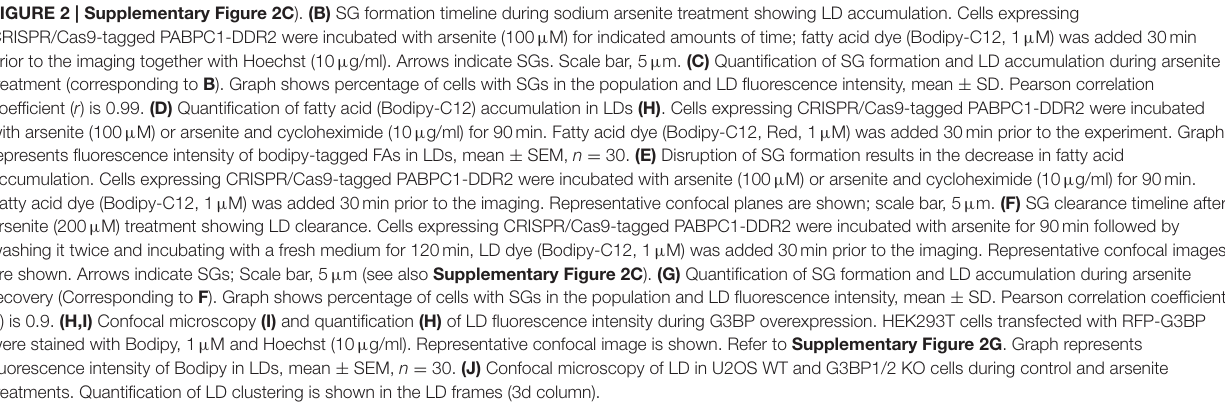
FIGURE 2 | Supplementary Figure 2C ). (B) SG formation timeline during sodium arsenite treatment showing LD accumulation. Cells expressing CRISPR/Cas9-tagged PABPC1-DDR2 were incubated with arsenite (100 µ M) for indicated amounts of time; fatty acid dye (Bodipy-C12, 1 µ M) was added 30min prior to the imaging together with Hoechst (10 µ g/ml). Arrows indicate SGs. Scale bar, 5 µ m. (C) Quantification of SG formation and LD accumulation during arsenite treatment (corresponding to B ). Graph shows percentage of cells with SGs in the population and LD fluorescence intensity, mean ± SD. Pearson correlation coefficient ( r ) is 0.99. (D) Quantification of fatty acid (Bodipy-C12) accumulation in LDs (H) . Cells expressing CRISPR/Cas9-tagged PABPC1-DDR2 were incubated with arsenite (100 µ M) or arsenite and cycloheximide (10 µ g/ml) for 90min. Fatty acid dye (Bodipy-C12, Red, 1 µ M) was added 30min prior to the experiment. Graph represents fluorescence intensity of bodipy-tagged FAs in LDs, mean ± SEM, n = 30. (E) Disruption of SG formation results in the decrease in fatty acid accumulation. Cells expressing CRISPR/Cas9-tagged PABPC1-DDR2 were incubated with arsenite (100 µ M) or arsenite and cycloheximide (10 µ g/ml) for 90min. Fatty acid dye (Bodipy-C12, 1 µ M) was added 30min prior to the imaging. Representative confocal planes are shown; scale bar, 5 µ m. (F) SG clearance timeline after arsenite (200 µ M) treatment showing LD clearance. Cells expressing CRISPR/Cas9-tagged PABPC1-DDR2 were incubated with arsenite for 90min followed by washing it twice and incubating with a fresh medium for 120min, LD dye (Bodipy-C12, 1 µ M) was added 30min prior to the imaging. Representative confocal images are shown. Arrows indicate SGs; Scale bar, 5 µ m (see also Supplementary Figure 2C ). (G) Quantification of SG formation and LD accumulation during arsenite recovery (Corresponding to F ). Graph shows percentage of cells with SGs in the population and LD fluorescence intensity, mean ± SD. Pearson correlation coefficient ( r ) is 0.9. (H,I) Confocal microscopy (I) and quantification (H) of LD fluorescence intensity during G3BP overexpression. HEK293T cells transfected with RFP-G3BP were stained with Bodipy, 1 µ M and Hoechst (10 µ g/ml). Representative confocal image is shown. Refer to Supplementary Figure 2G . Graph represents fluorescence intensity of Bodipy in LDs, mean ± SEM, n = 30. (J) Confocal microscopy of LD in U2OS WT and G3BP1/2 KO cells during control and arsenite treatments. Quantification of LD clustering is shown in the LD frames (3d